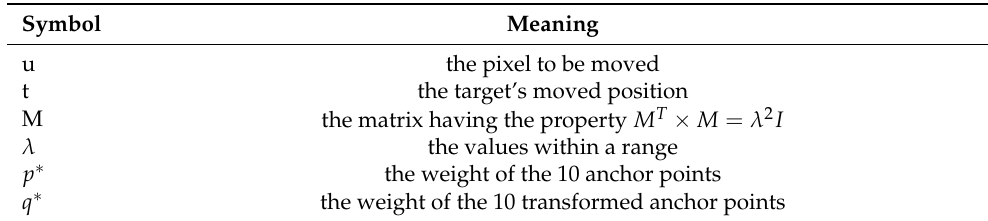
Table A1. Variable Definitions of Projection